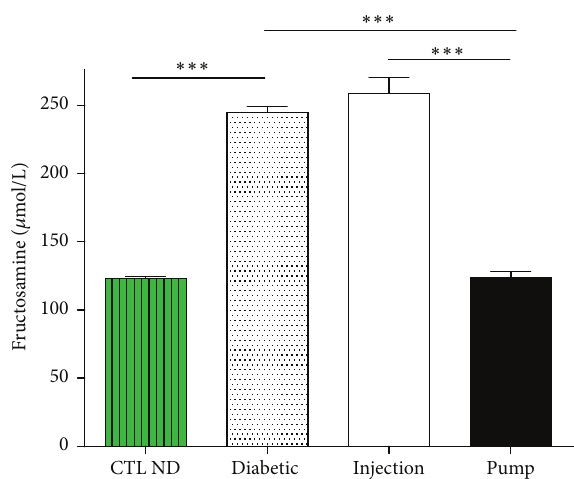
Figure 6: Plasma fructosamine level at time of sacrifice (30 days). Diabetic rats had a higher level of fructosamine than control nondiabetic (CTL ND) rats. Injection rats had a level comparable to the diabetic rats, whereas the level in pump rats was the same as CTL ND rats. ∗∗∗ 𝑝 < 0.01